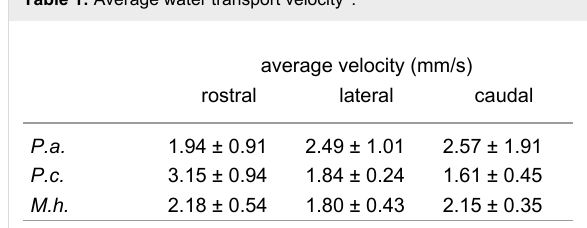
Table 1: Average water transport velocity a